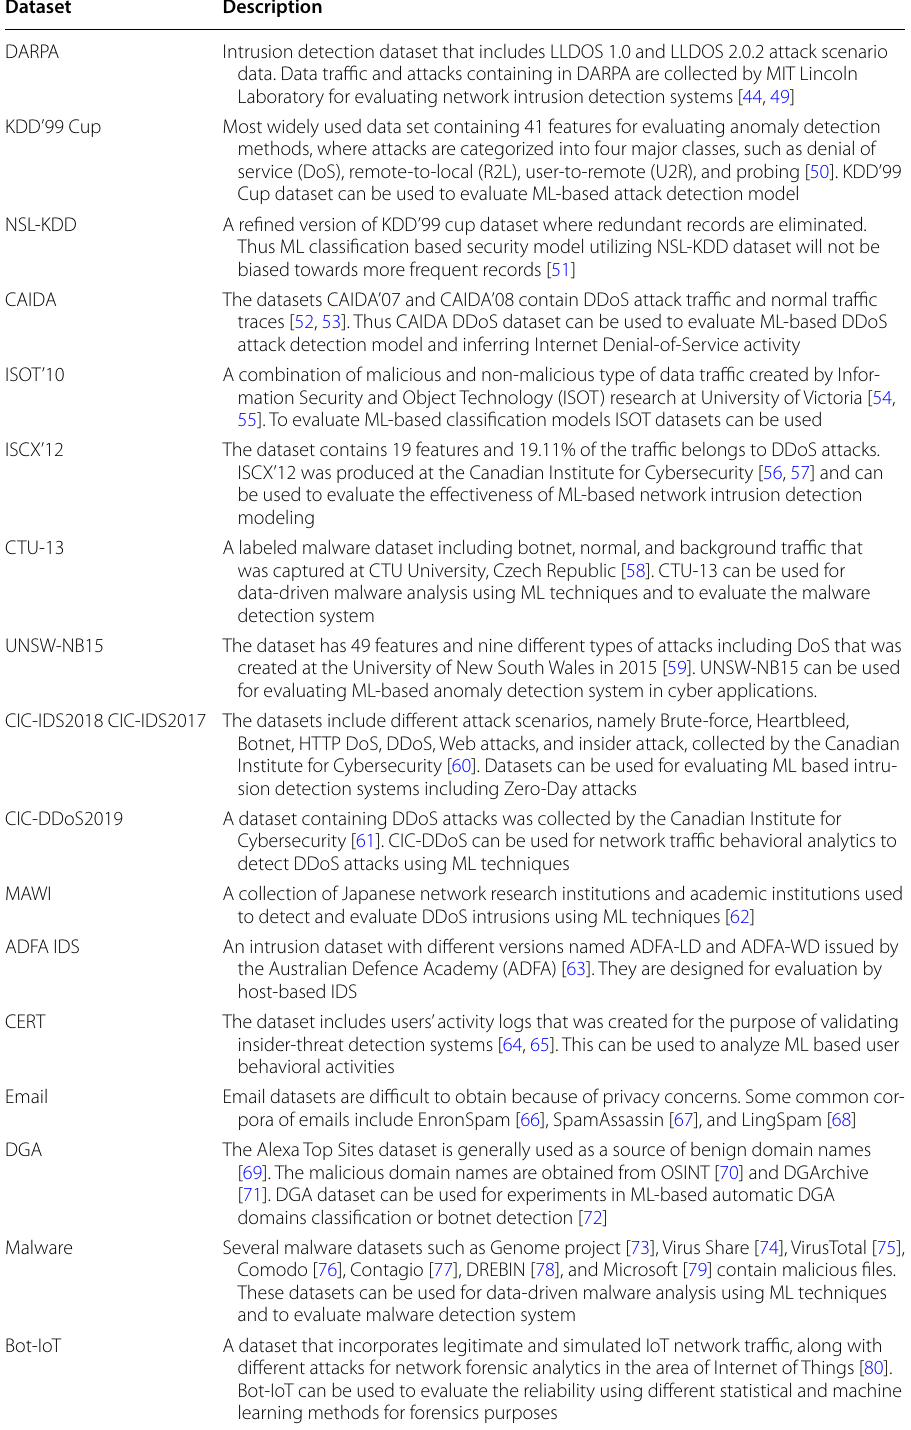
Table 2 A summary of cybersecurity datasets highlighting diverse attack-types and machine learning-based usage in different cyber